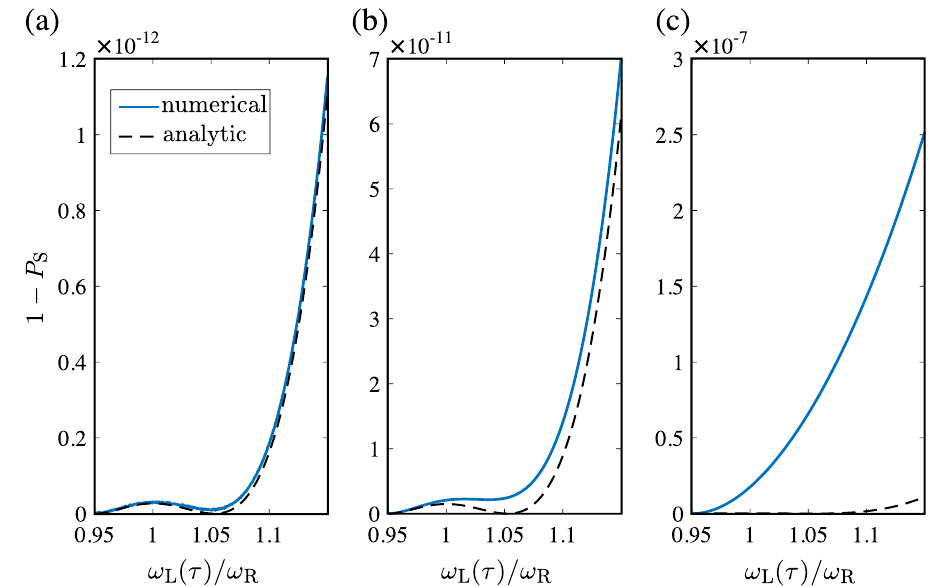
Fig. 3 Ground-state sudden sweep fi delity 1 − P S as a function of the control parameter value ω L ( τ ) at the end of the protocol. We compare the analytically obtained sweep fi delity in Eq. (15) with that obtained by fi nding the ground state | Ψ 0 ( t ) 〉 numerically. We show the data for